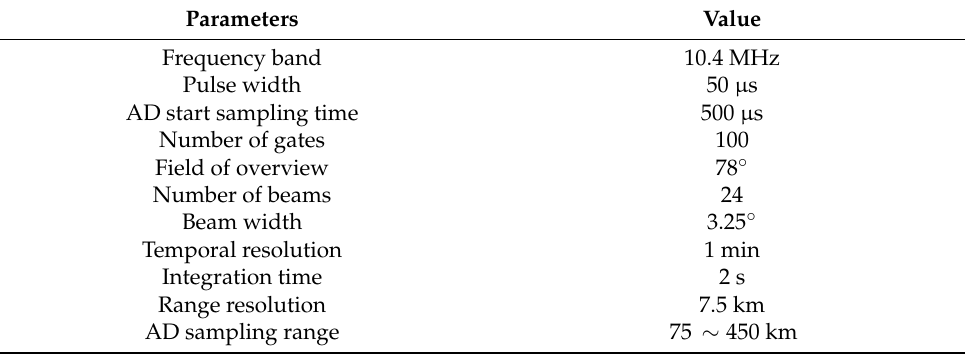
Table 2. Working parameters of AgileDARN for observing meteor targets.